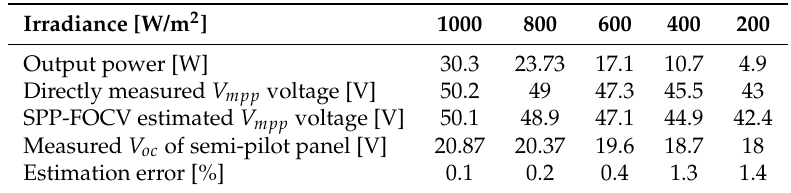
Table 10. Experimental comparison between directly measured and SPP-FOCV estimated V mpp voltage for different irradiance values. The temperature of the PV cells is 25 ◦ C.